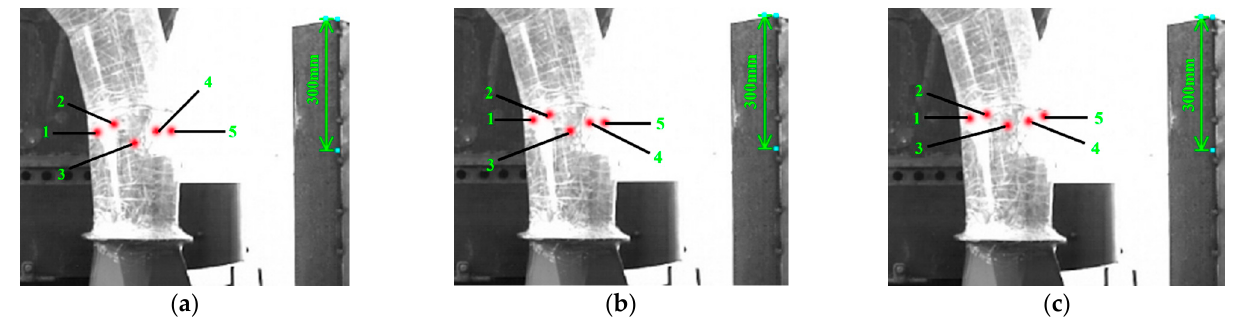
Figure 17. Movement process of crushed straw material near section B. ( a ) t = 1.553 s. ( b ) t = 1.555 s. ( c ) t = 1.557 s.